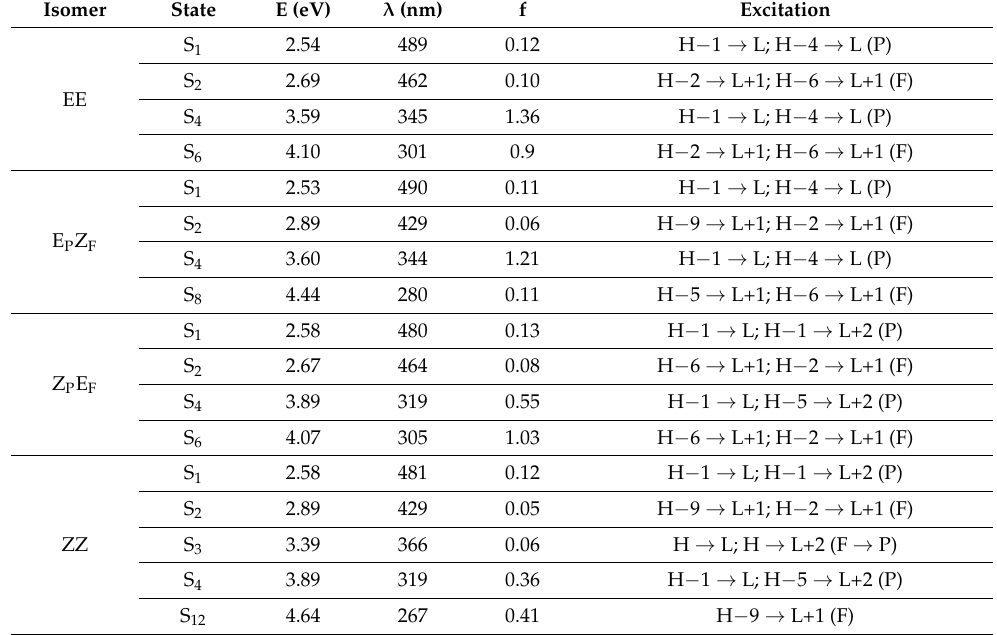
Table 2. Relevant lowest electronic excited states of the four E/Z stable isomers of dimer